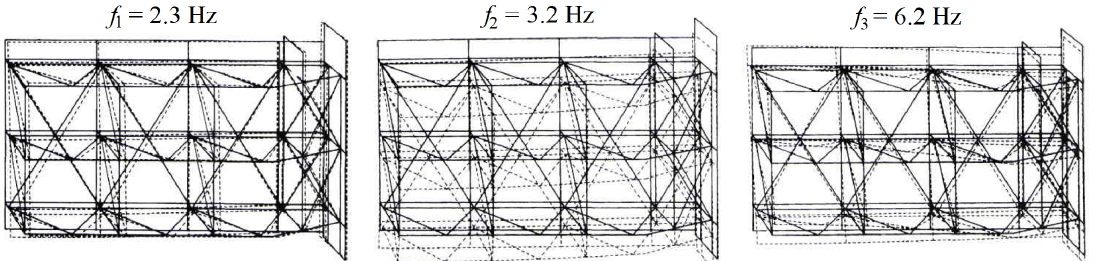
Figure 3. Example: First three modal shapes and frequencies of single gate in Eastern Scheld Storm Surge Barrier adapted from [20], with permission from RWS, 2020. Width * height ≈ 45 × 28 m. Modal periods include the effects of fluid–structure interaction.